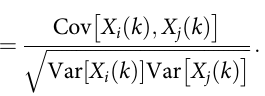
v g ð T int Þ ¼ G , where G is a constant. Then from Eq. 1, the